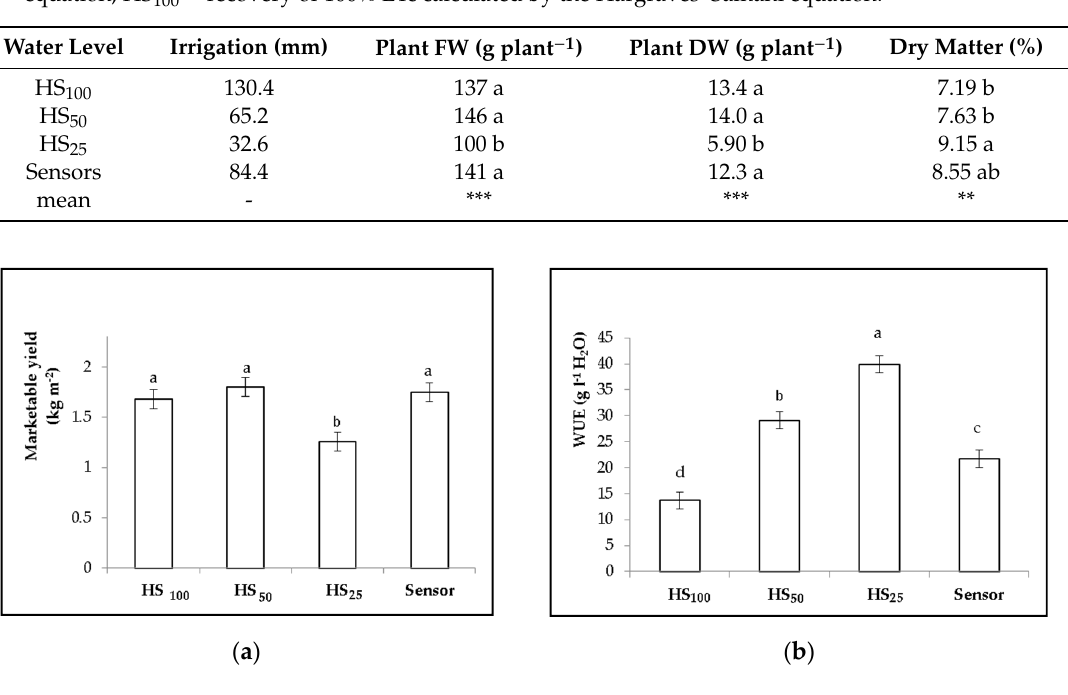
Table 4. Experiment 2: Effect of the irrigation strategy and soil mulching on the physiological parameters of lettuce. Significance codes: *, significant at p ≤ 0.05; **, significant at p ≤ 0.01; ***, significant at p ≤ 0.001, “Ns” = not significant. Stomatal Conductance (mmol m − 2 s − 1 ) Leaf Temperature (°C) SPAD